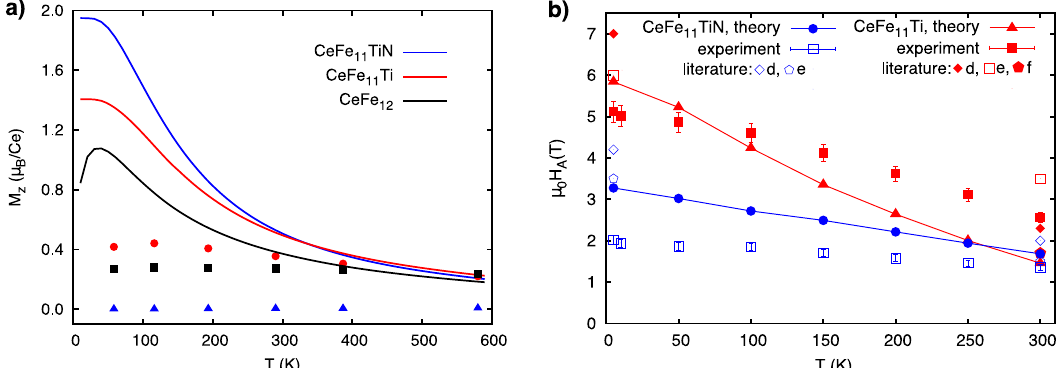
Fig. 2 Temperature dependence of Ce-4 f magnetism in Ce – Fe “ 1 – 12 ” . a Calculated temperature dependence of the Ce-4 f magnetic moments M z in CeFe 12 (black squares), CeFe 11 Ti (red circles), and CeFe 11 TiN (blue triangles). At low temperatures the Kondo-screened Ce-4 f magnetic moments (symbols) are much smaller than their expected quasi-atomic values (solid lines). The Kondo effect is the strongest in CeFe 11 TiN. b Temperature dependence of the anisotropy fi eld H A (Tesla) in CeFe 11 Ti (in red) and CeFe 11 TiN (in blue). In addition to the theoretical and experimental results obtained in this work, values from (d) ref. 20 , (e) ref. 21 , and (f) ref. 4 are shown for